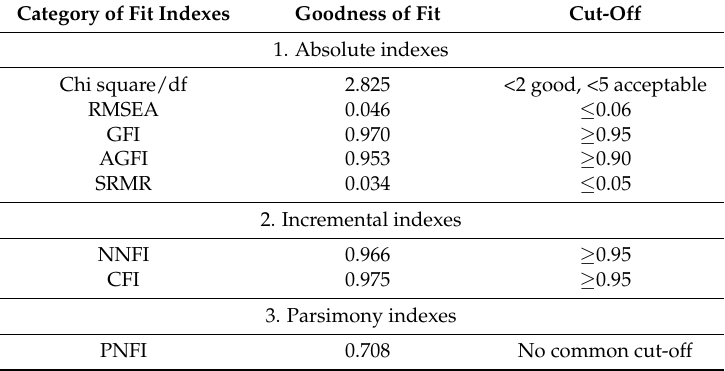
Table 4. Evaluation of